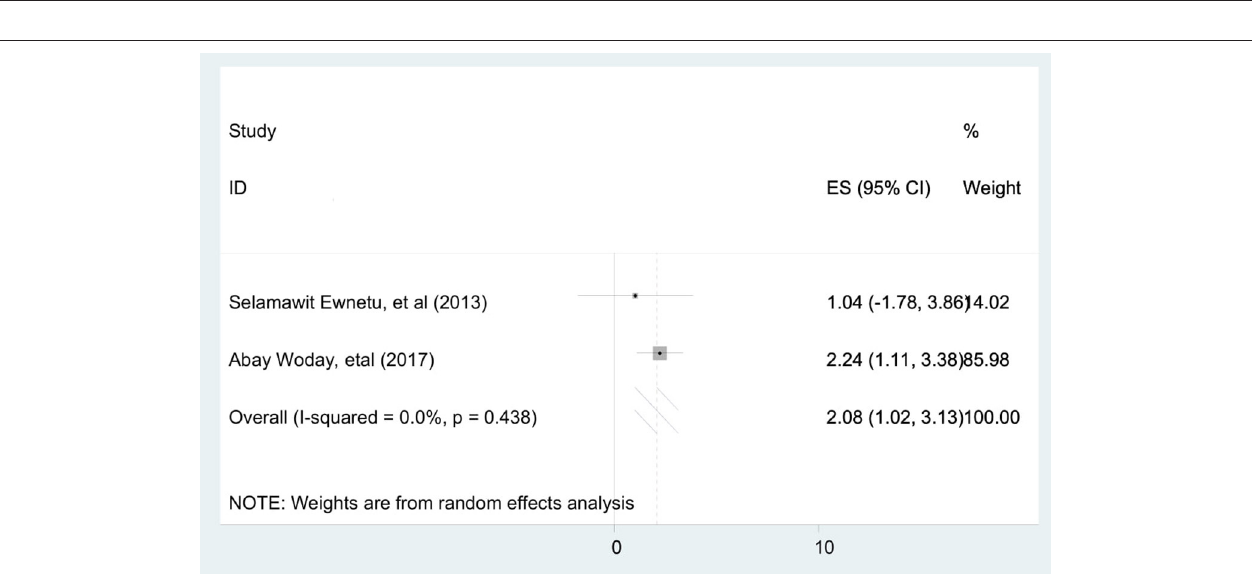
FIGURE 5 | Forest plot to show the association between maternal age of < 30 years and pooled prevalence of stillbirths among diabetic pregnant mothers in Ethiopia,